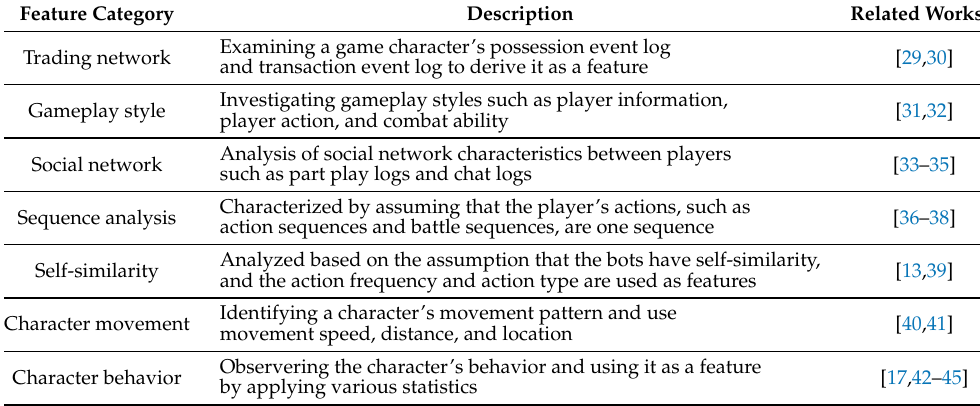
Table 1. Classification of features used in game bot detection. Feature